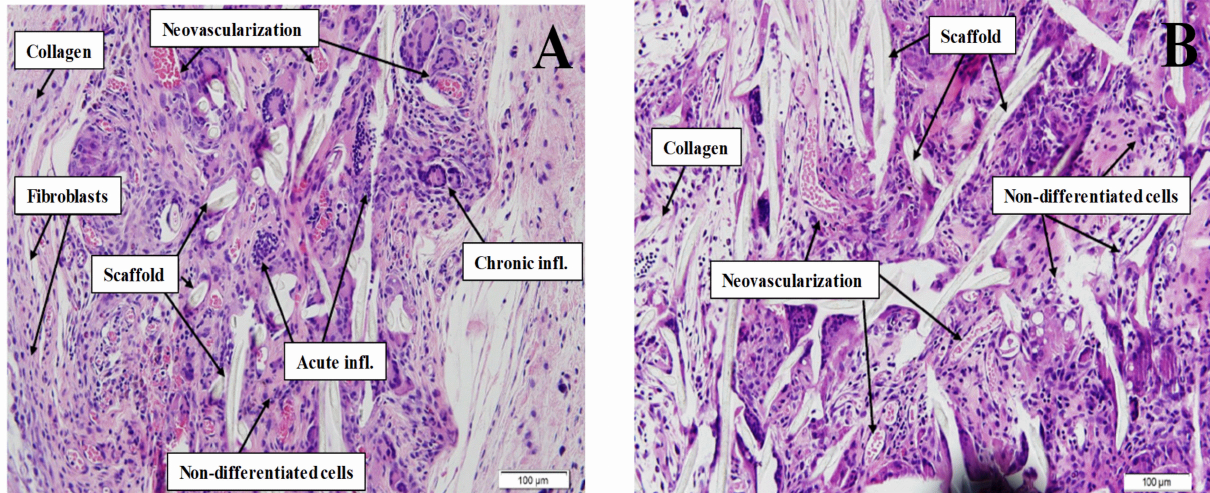
Figure 4. H&E photomicrographs (magnification of 2 × ) of the ( A ) static and ( B ) dynamic PCL/elastin scaffolds seeded with cells. Different aspects were shown with arrows: collagen formation, neovascularization, undifferentiated cells, inflammations and marks of the presence of the